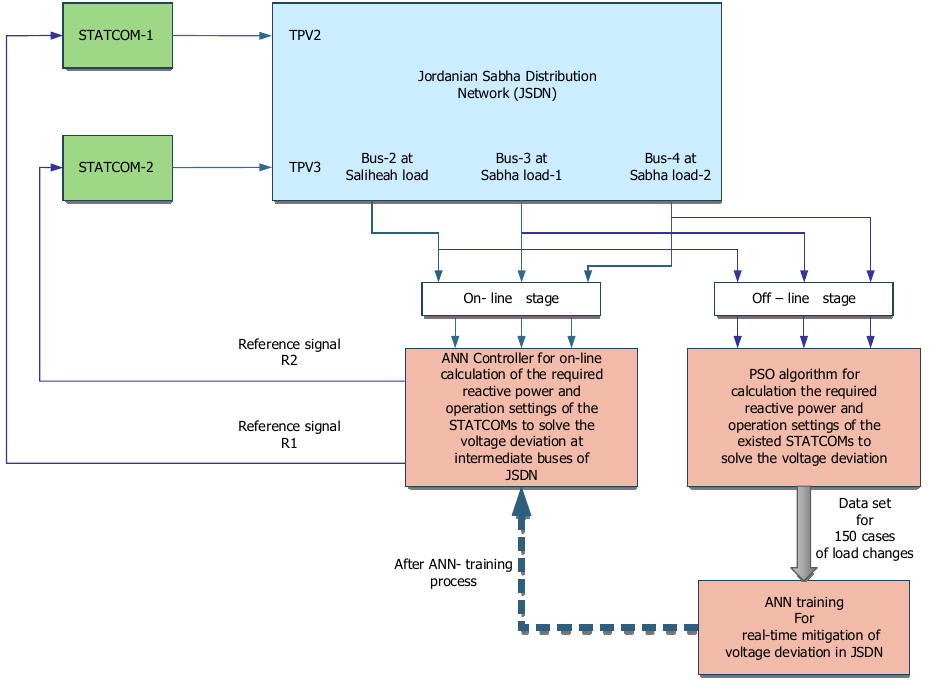
Figure 4. Schematic diagram of the technical route. Table 6. PSO Results Using Two STATCOMs at TPV2 & TPV3 Buses of Badiah PV